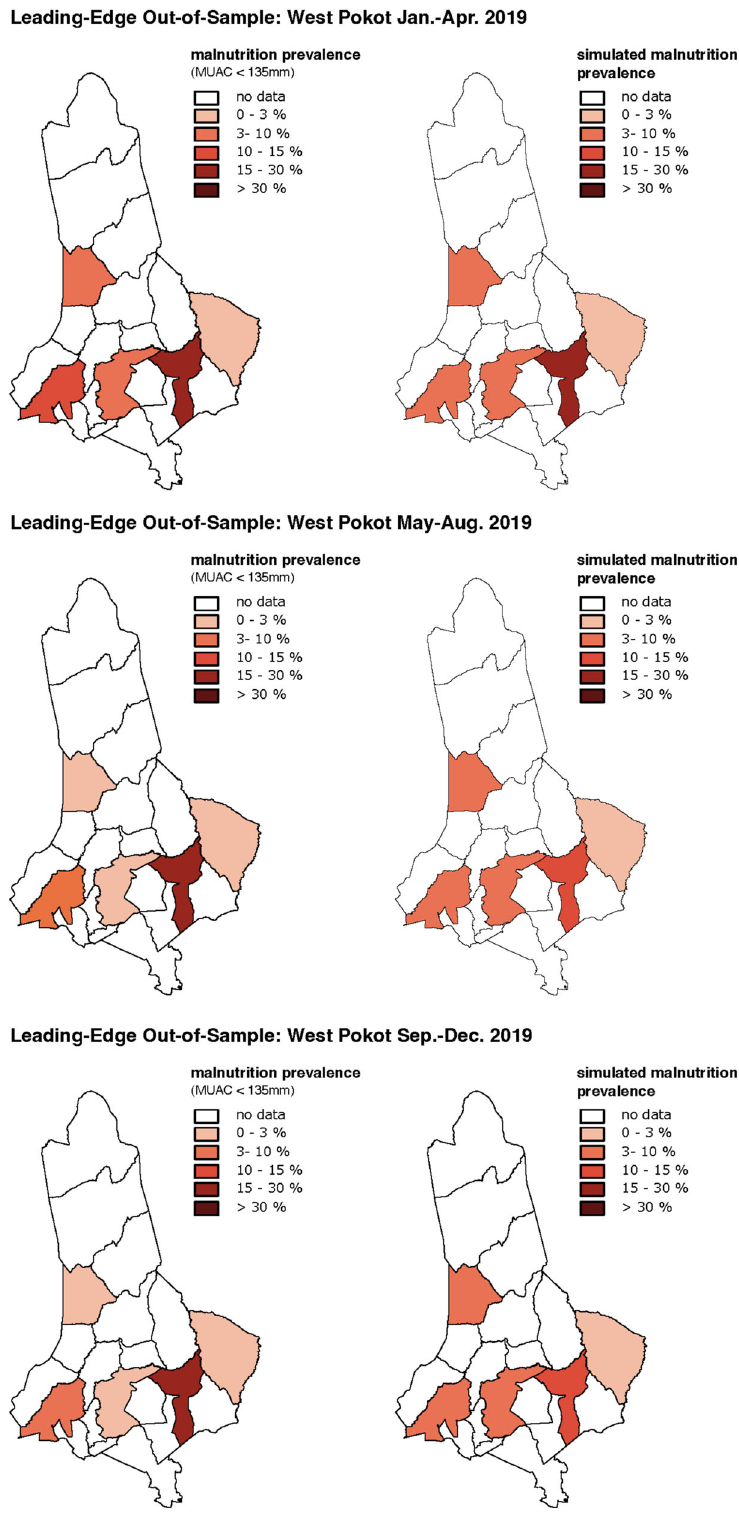
Fig. 4 Observed vs. simulated 4-month leading-edge predictions of malnutrition prevalence in West Pokot (2019). Top panel: Jan. – Apr. Middle panel: May – Aug. Bottom panel: Sep. – Dec. Prevalence is measured using the MUAC measure, and is displayed at the